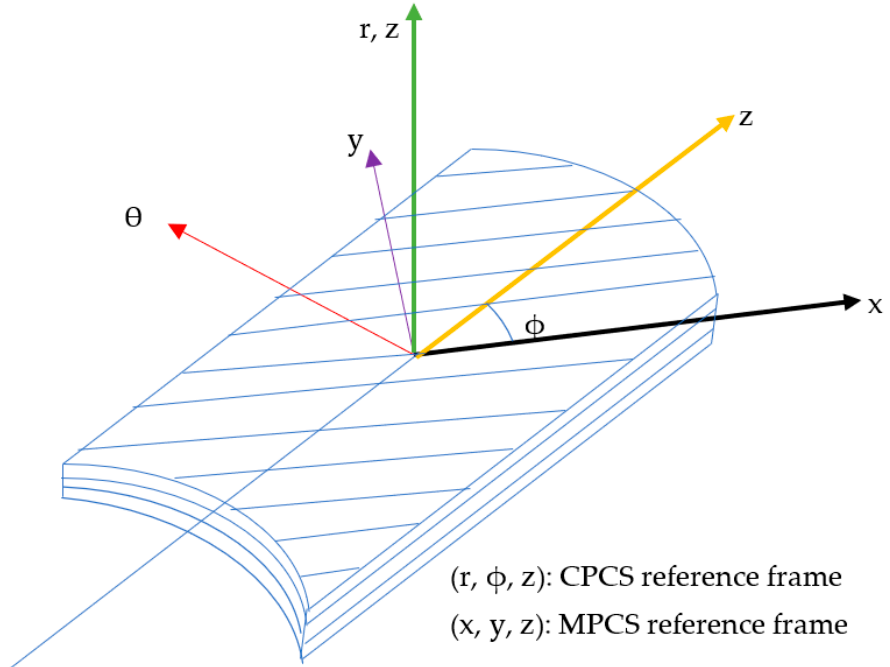
Figure 3. Representation of cylindrical coordinate and material principal coordinate systems.